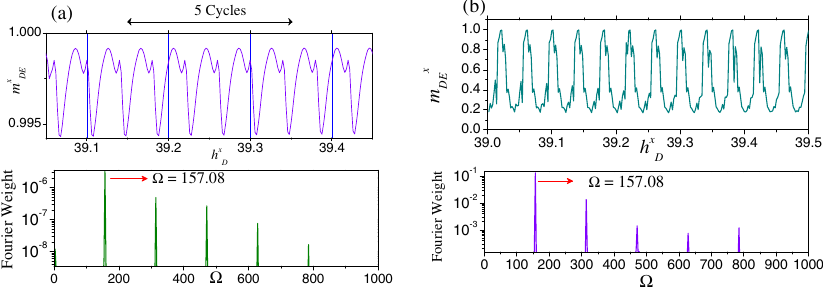
FIG. 5. Periodicity in drive strength, h x D , of the magnetization response [diagonal ensemble average m x periodicity for both off-resonance (left, h x 0 ¼ − 0 . 2 ) and on-resonance (right, h x 0 ¼ − 0 . 21 ) drives. Other parameters and the initial low- temperature state, as in Fig. 2(b). In both cases, the leading frequency of oscillations is Ω ≈ 157 . 08 ≈ 2 π = ω , visible in the bottom panel, as predicted by Eq. (43). The other parameters are the same as in Fig. 1(a).